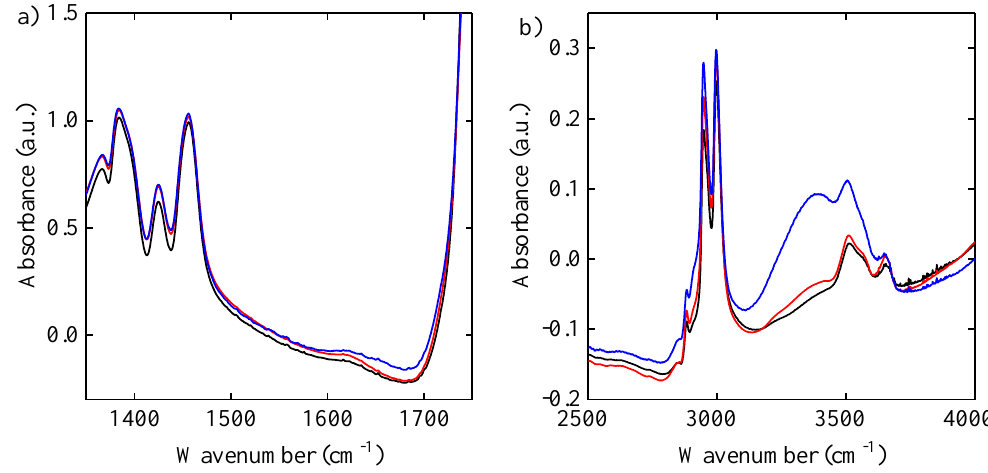
Figure 2. FTIR spectra of blank microspheres (solid black line), low polypeptide loaded (solid red line) and high polypeptide loaded (solid blue line) PLGA 75:25 microspheres. ( a ) shows the wavenumber range of 1300 − 1700cm − 1 and ( b ) shows the wavenumber range of 2500–4000 cm − 1 .